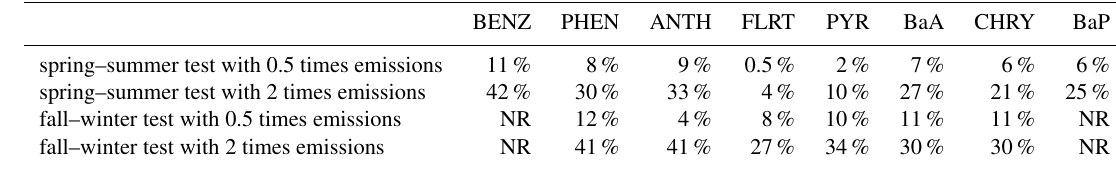
Table 2. Domain-wide average on-road vehicle contributions to ambient concentrations, when on-road vehicle emissions of BENZ and PAHs are halved or doubled. “NR” represents not reported.